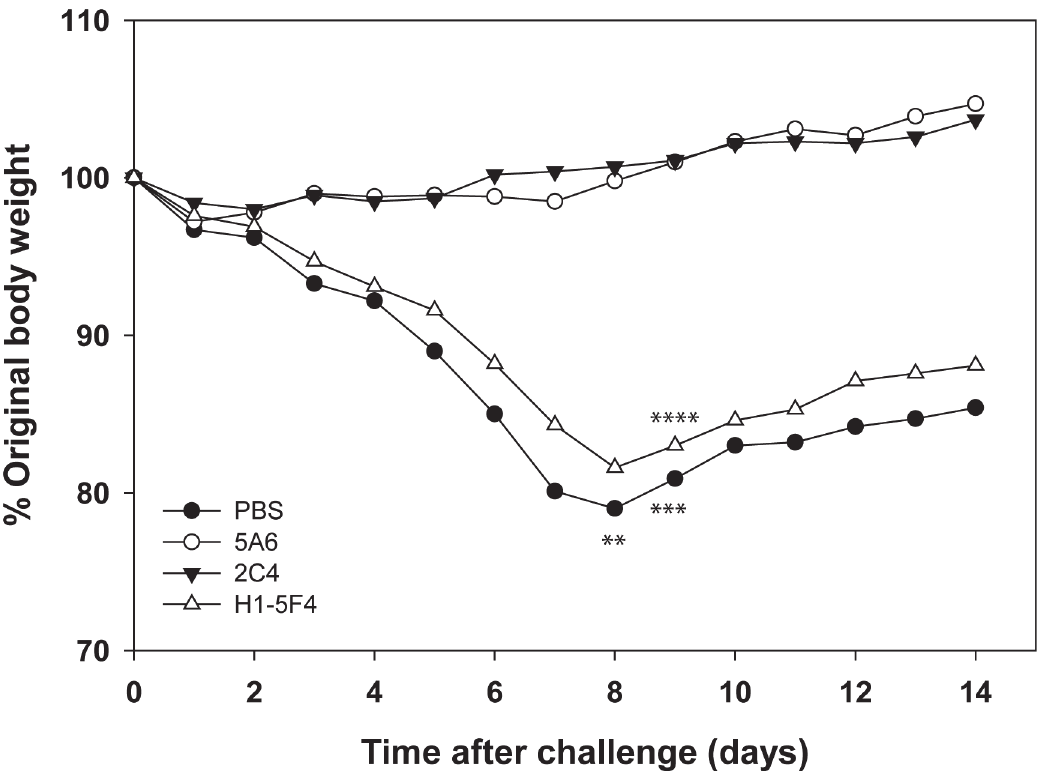
Figure 3. Protection of mice from A/Shanghai/2/2013 challenge. PBS or the indicated mAb (100 μ g) were transferred by the intraperitoneal route to mice (groups of 5) approximately 6 hours before being challenged intranasally with A/Shanghai/2/2013. Animals were observed for 2 weeks for weight loss and/or death, and the average percentage change in body weight and deaths ( * ) in each group are shown. Data are the average (mean) of two replicate